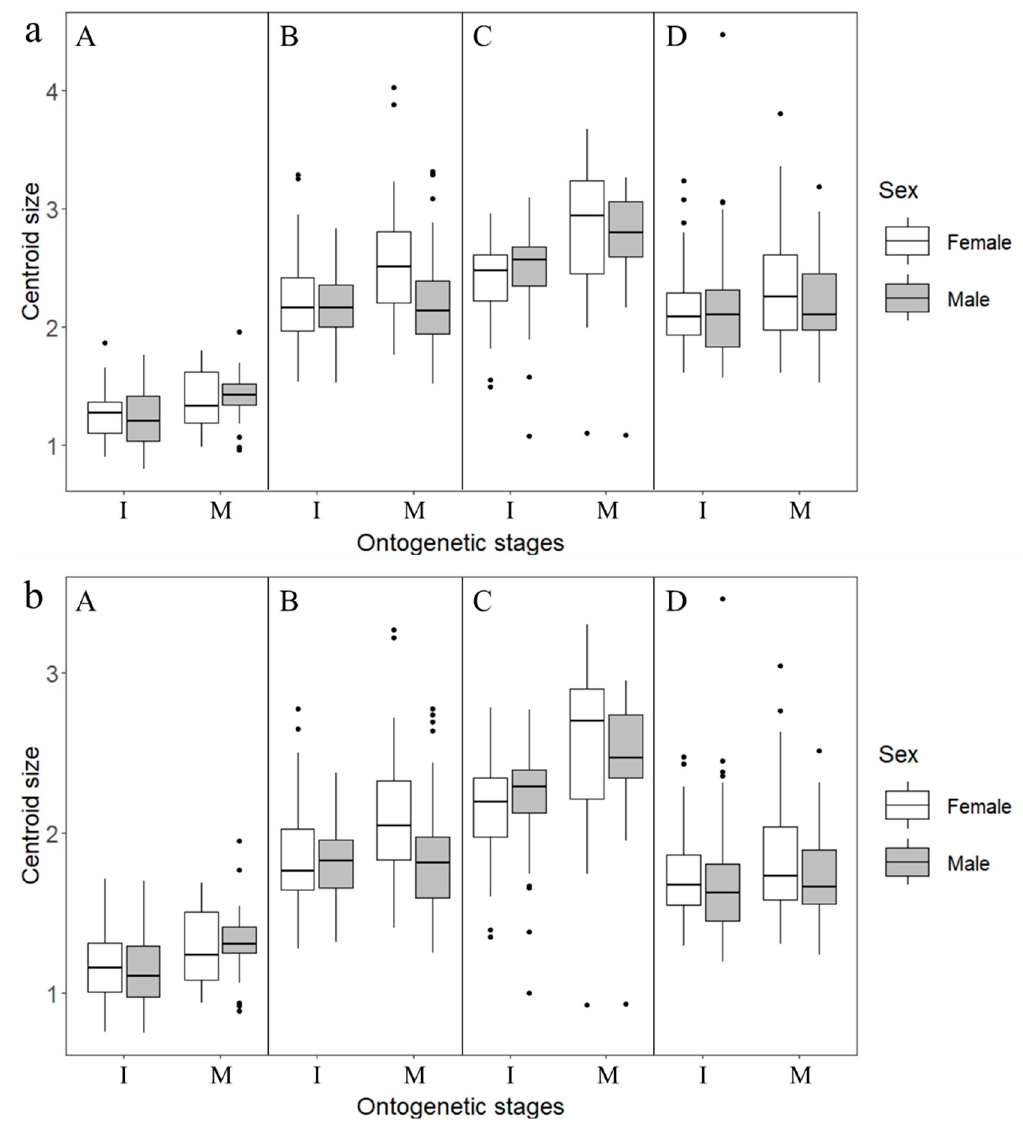
Figure 2. Beak centroid size variation of four cephalopods in different ontogenetic stages. ( a ): Upper beak; ( b ): Lower beak. I: Immature stages; M: Mature stages; A: Octopus minor ; B: Uroteuthis edulis ; C: Sepia esculenta ; D: Sthenoteuthis oualaniensis.